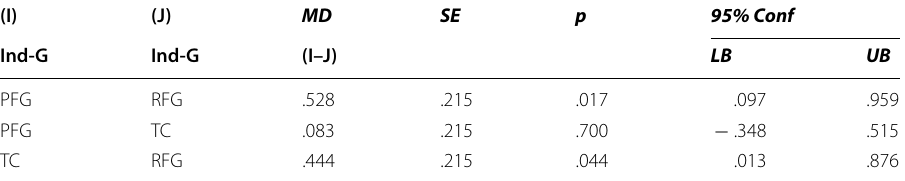
Table 6 Results of the post hoc